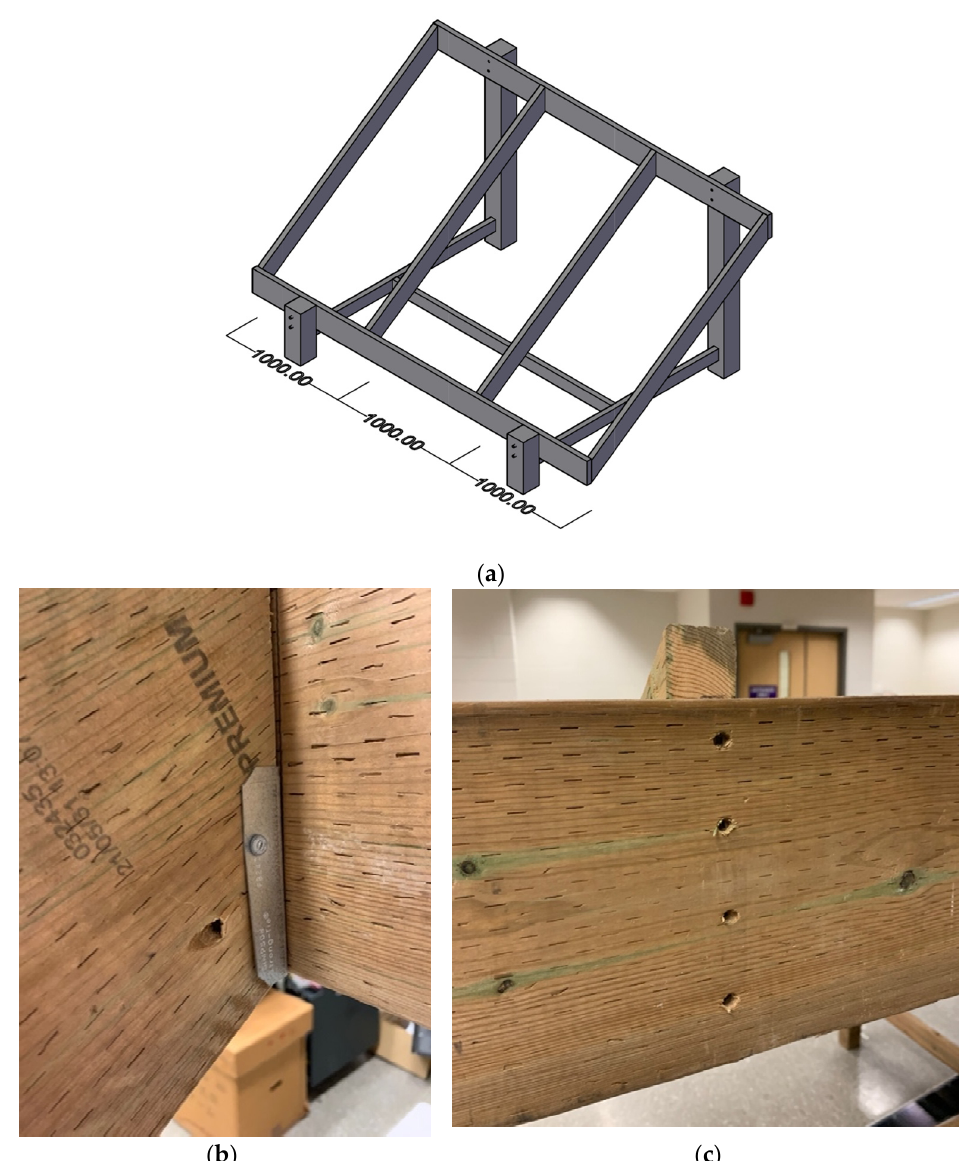
Figure 6. ( a ) Joist spanning specifications between the beams, ( b ) fence brackets with joist hanger nails to be installed at the bottom of the joists, and ( c ) 4 brown deck screws installed from behind the beam.